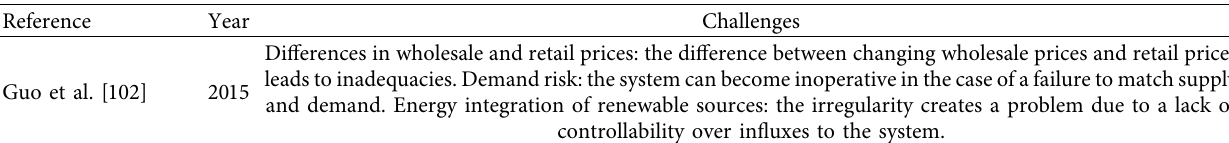
Table 4: Socioeconomic challenges of smart